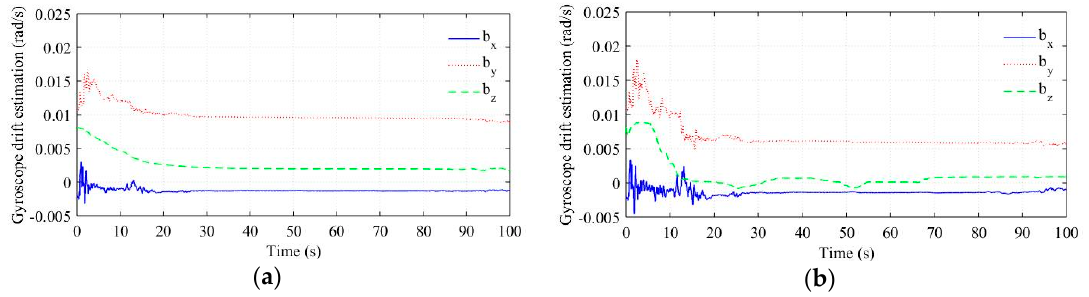
Figure 6. Gyroscope bias estimation. ( a ) Conventional algorithm. ( b ) Improved algorithm.